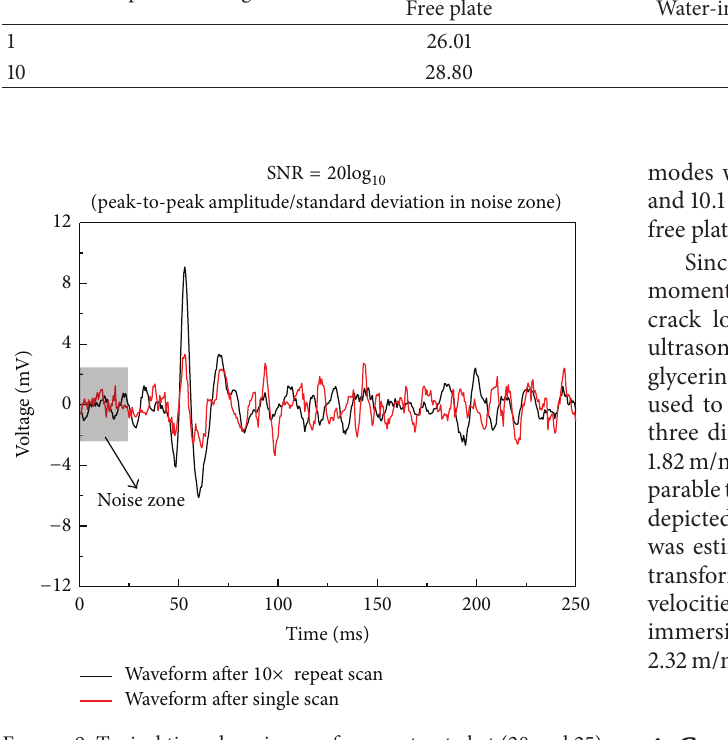
Figure 9: Typical time domain waveforms extracted at (20 and 25) in Figures 6(a) and 8(b) for SNR evaluation (waveform comparison after single scan and 10 × repeat scan for water-immersed plate condition) and definition for SNR